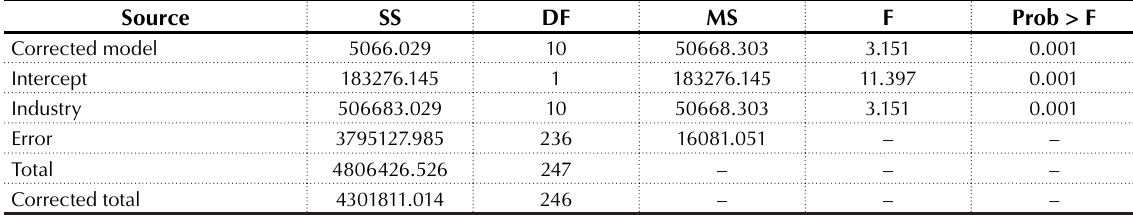
Table 5. One-way analysis of variance for comparison of stock prices within